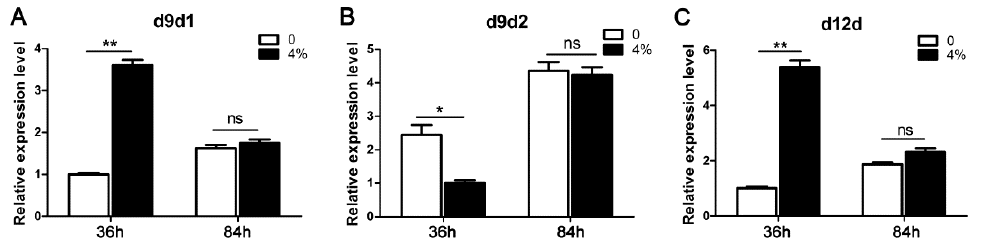
Figure 6. The e ff ects of ethanol treatment on the expressions of ∆ 9 -desaturase (D9d) and ∆ 12 -desaturase (D12d) in linoleic acid biosynthesis 36 and 84 h post-treatment. Asterisks indicate statistically significant di ff erences between groups (Student’s t -test): * denotes p < 0.05; ** denotes p < 0.01; ns: no significant di ff erence.